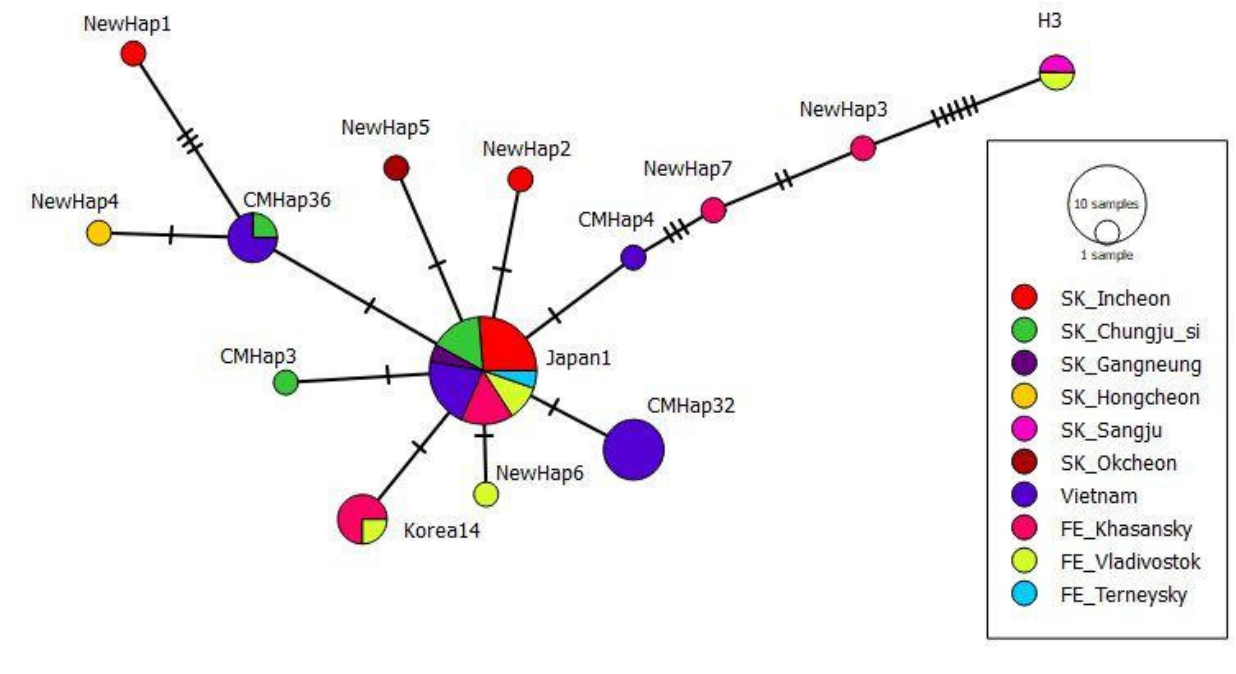
Figure 3. The genetic structure of the studied Apis cerana samples: 1—sample from South Korea, 2— samples from Vietnam (subspecies A. c. indica , except for specimens marked *— A. c. cerana ) and 3— samples from the Russian Far East. K is the inferred number of clusters.